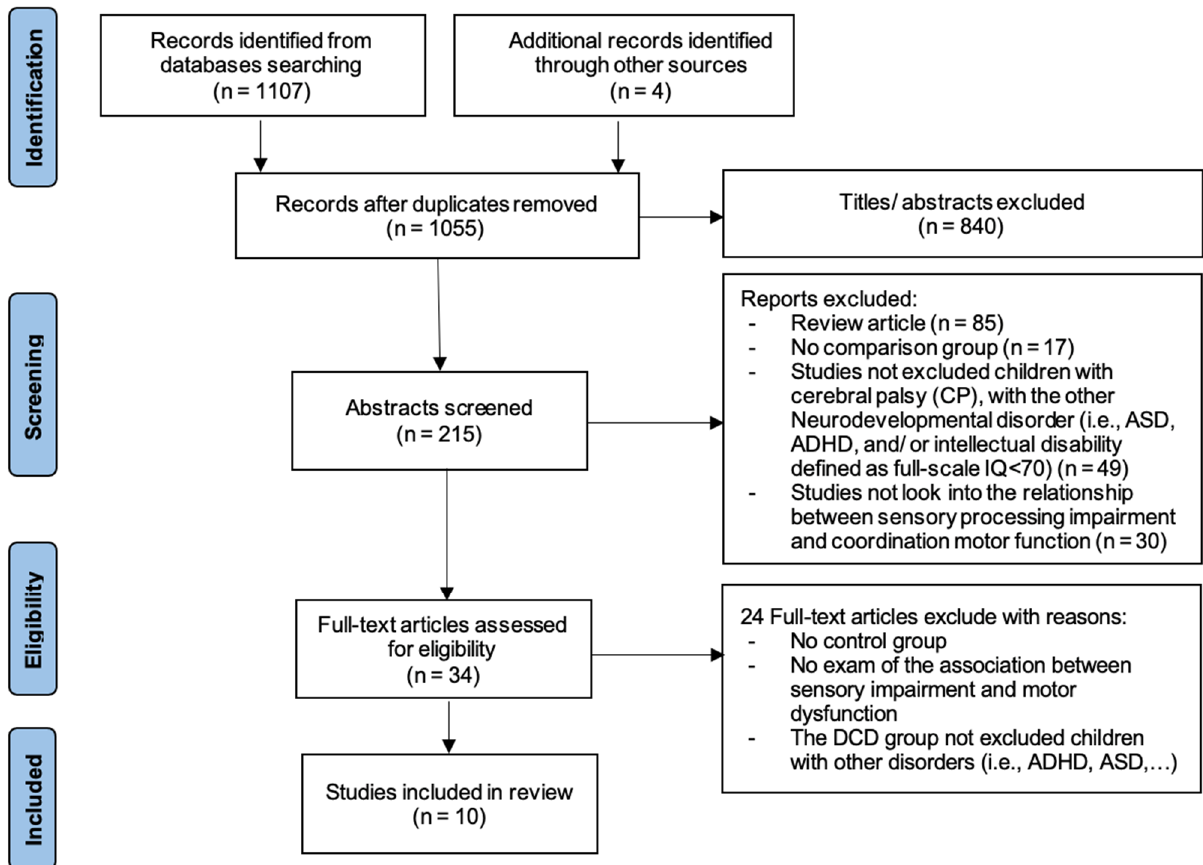
Figure 1. This is a figure. Schemes follow the same